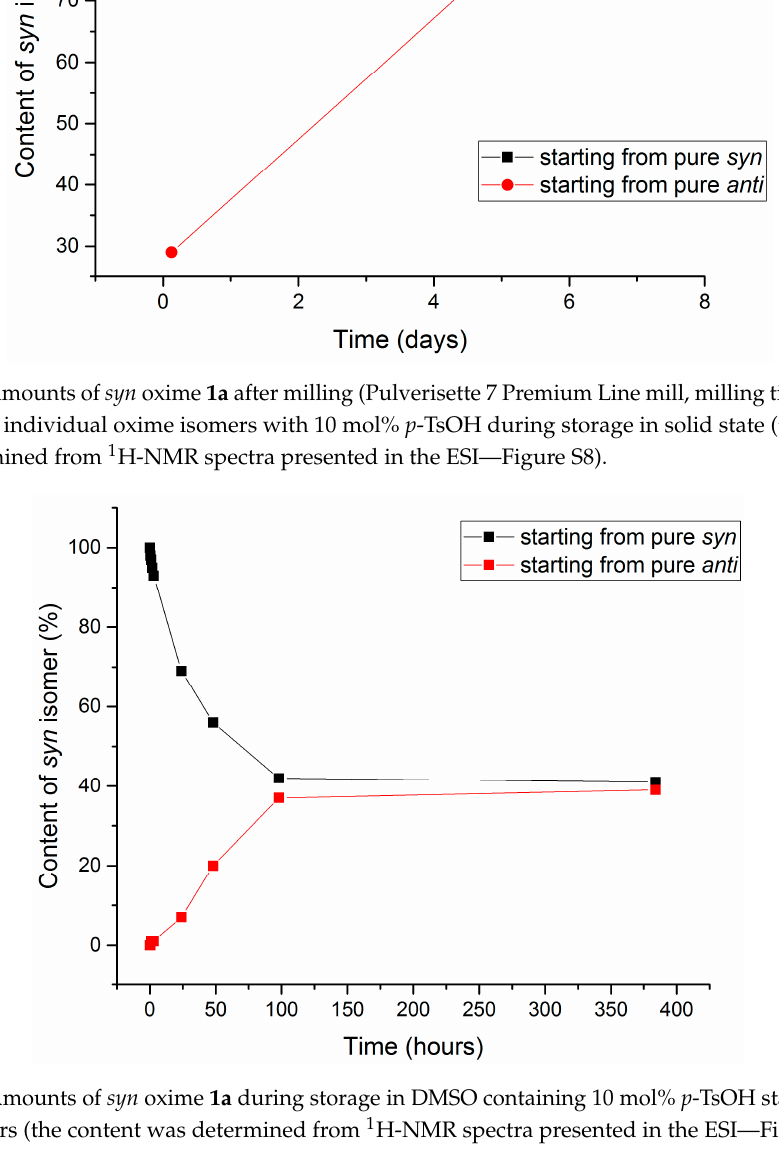
Figure 4. Amounts of syn oxime 1a after milling (Pulverisette 7 Premium Line mill, milling time 20 min) of the pure individual oxime isomers with 10 mol% p -TsOH during storage in solid state (the content was determined from 1 H-NMR spectra presented in the ESI—Figure S8).